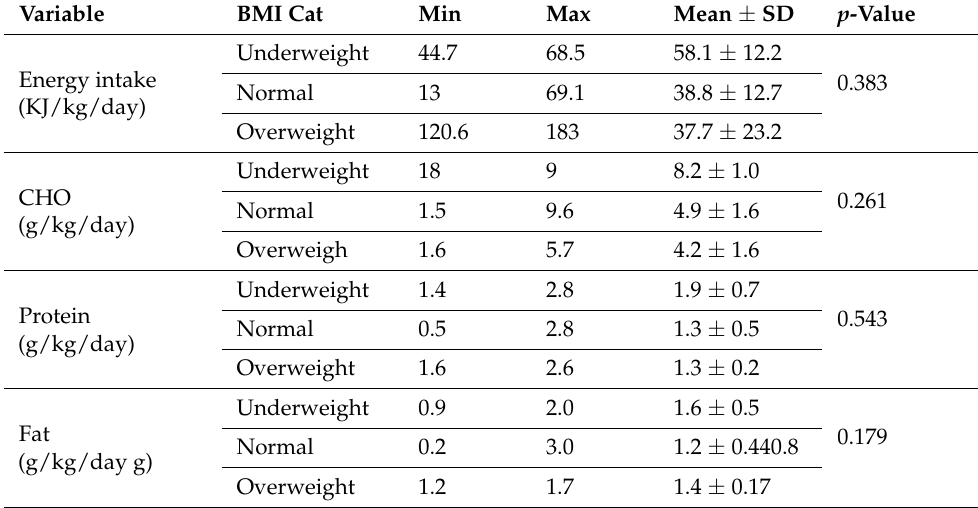
Table 5. Relationship between BMI and dietary